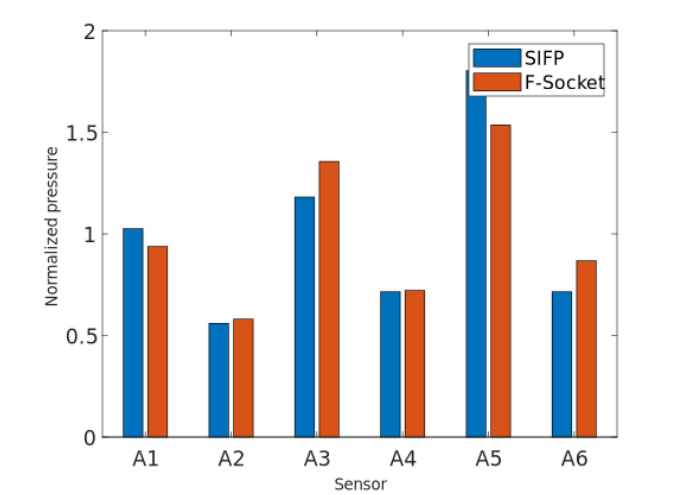
Figure 15. Graphical comparison of the normalized data between